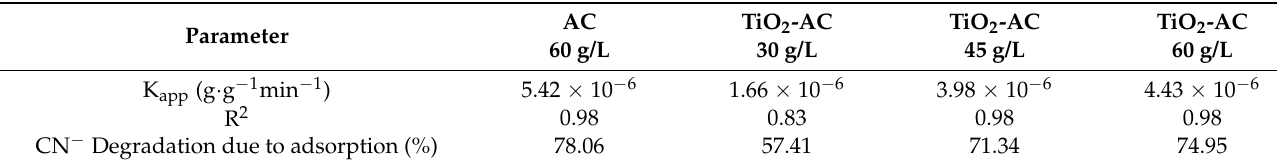
Table 4. Kinetic modeling of cyanide ion adsorption (pseudo ‐ second order).